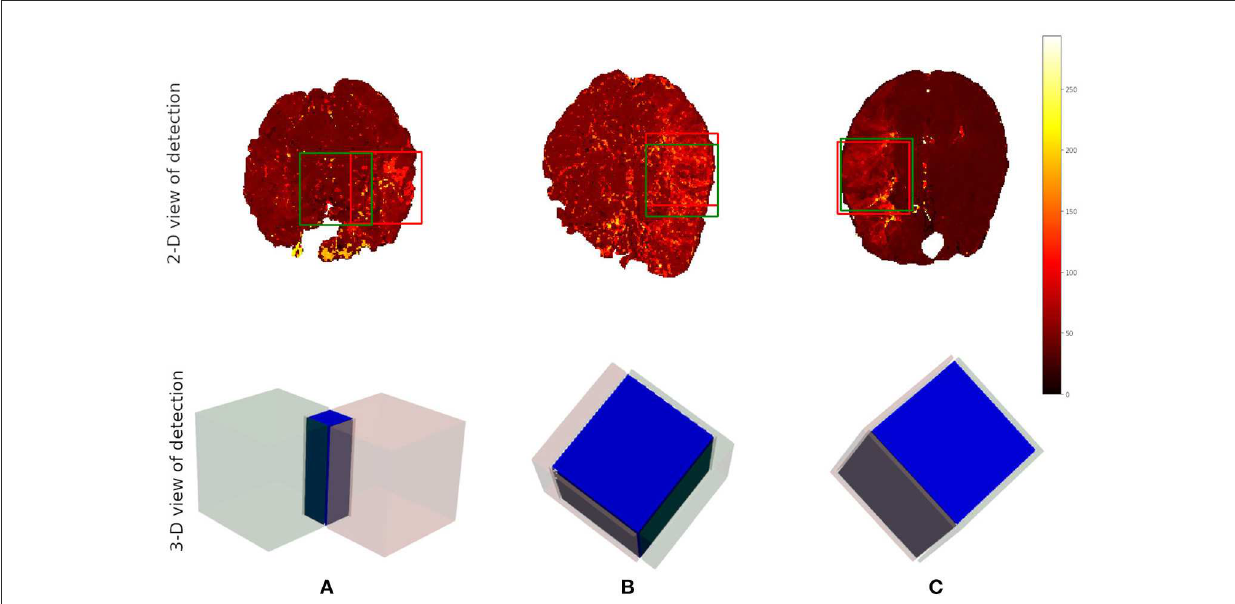
FIGURE4 Qualitative results from the ROI detection task. The top row is the axial view of the ground truth (in red) and the prediction (in green). The bottom row is a 3-D visualization of the ground truth cube (in red), the predicted cube (in green), and the intersection between the two (in blue). Column (A) corresponds to the worst prediction in our test set while column (C) refers to the best result in terms of IoU. In column (B) , we can observe that though the overlap is not perfect the prediction still contains some part of the occluded region which is not in the ground truth. This implies that though we have poor scores we still have good ROI detection which can be used for the classification task.